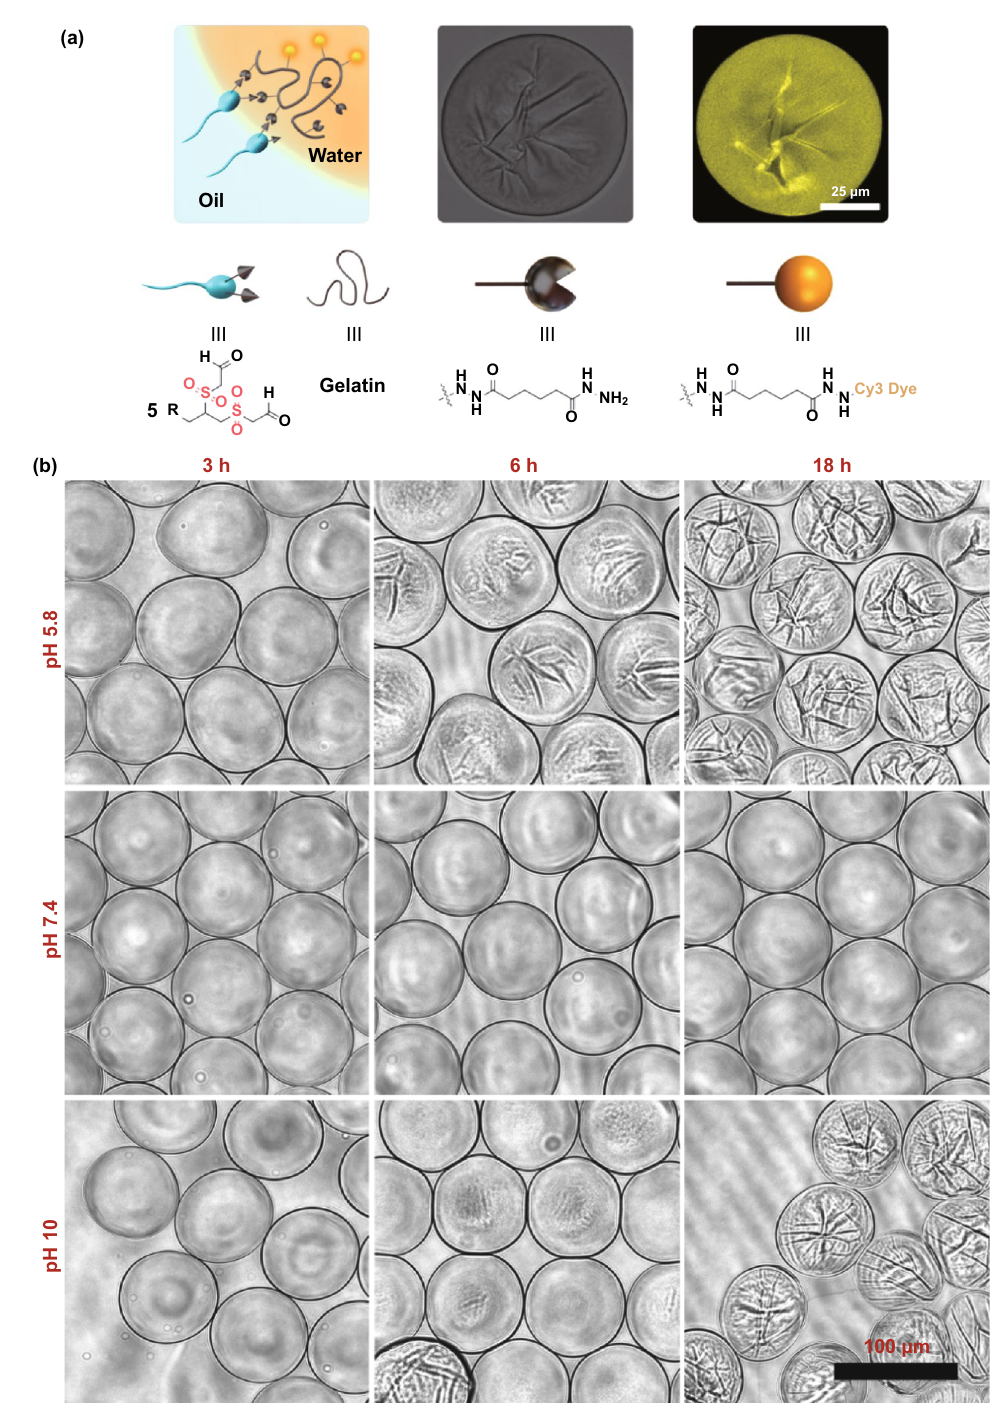
Fig. 4 One-step capsule fabrication a Capsule formation scheme showing the reaction between the surfactant’s ‑CHO groups and the gelatin‑ ADH’s hydrazide groups at the water–oil interface of a drop (orange background). Drops were generated by using the single drop‑maker PDMS device with two inlets for oil and aqueous solutions (used in Fig. 3A) and stabilized with surfactant 5 (left). 2D fluorescent (middle) and bright‑field (right) images of a capsule were recorded with a confocal microscope after 24 h of droplet generation. The inner phase of the capsule comprised of 1% gelatin‑ADH labeled with Cy‑3 dye in the pH 10 borate buffer. The distribution of the fluorescent intensity across the capsule indicated that the polymer was not adsorbed at the interface due to the reversible hydrazone formation process across the capsule. b Time and pH‑dependent capsule formation through reversible covalent bonds between 1% gelatin‑ADH (in the aqueous phase) and the surfactant 5 (at the droplet